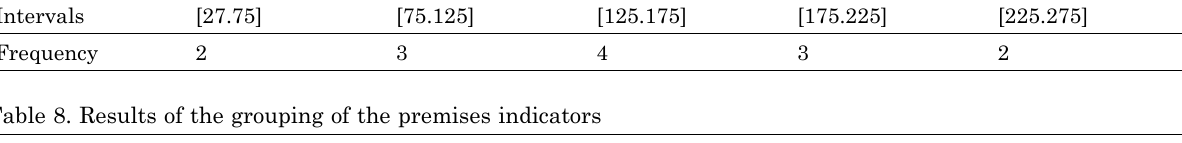
table 7. results of the grouping of the economic lease indicators Intervals